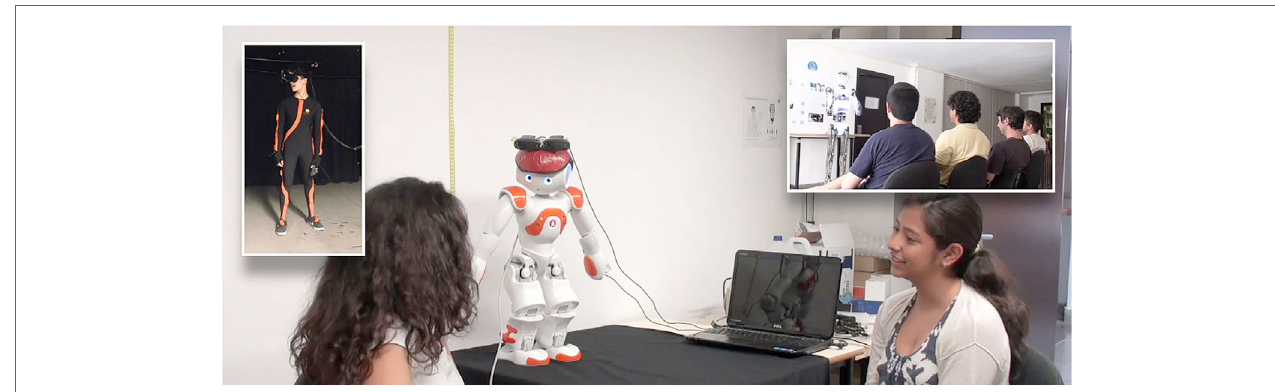
FigUre 5 | The visitor (top-left corner) is currently in PD2 having a social interaction with a friend . The visitor controls the robot’s head, and consequently, the view of the destination by simply looking toward the desired direction. Meanwhile, the Robothespian at PD1 continues interaction with the locals via the proxy (top-right corner).